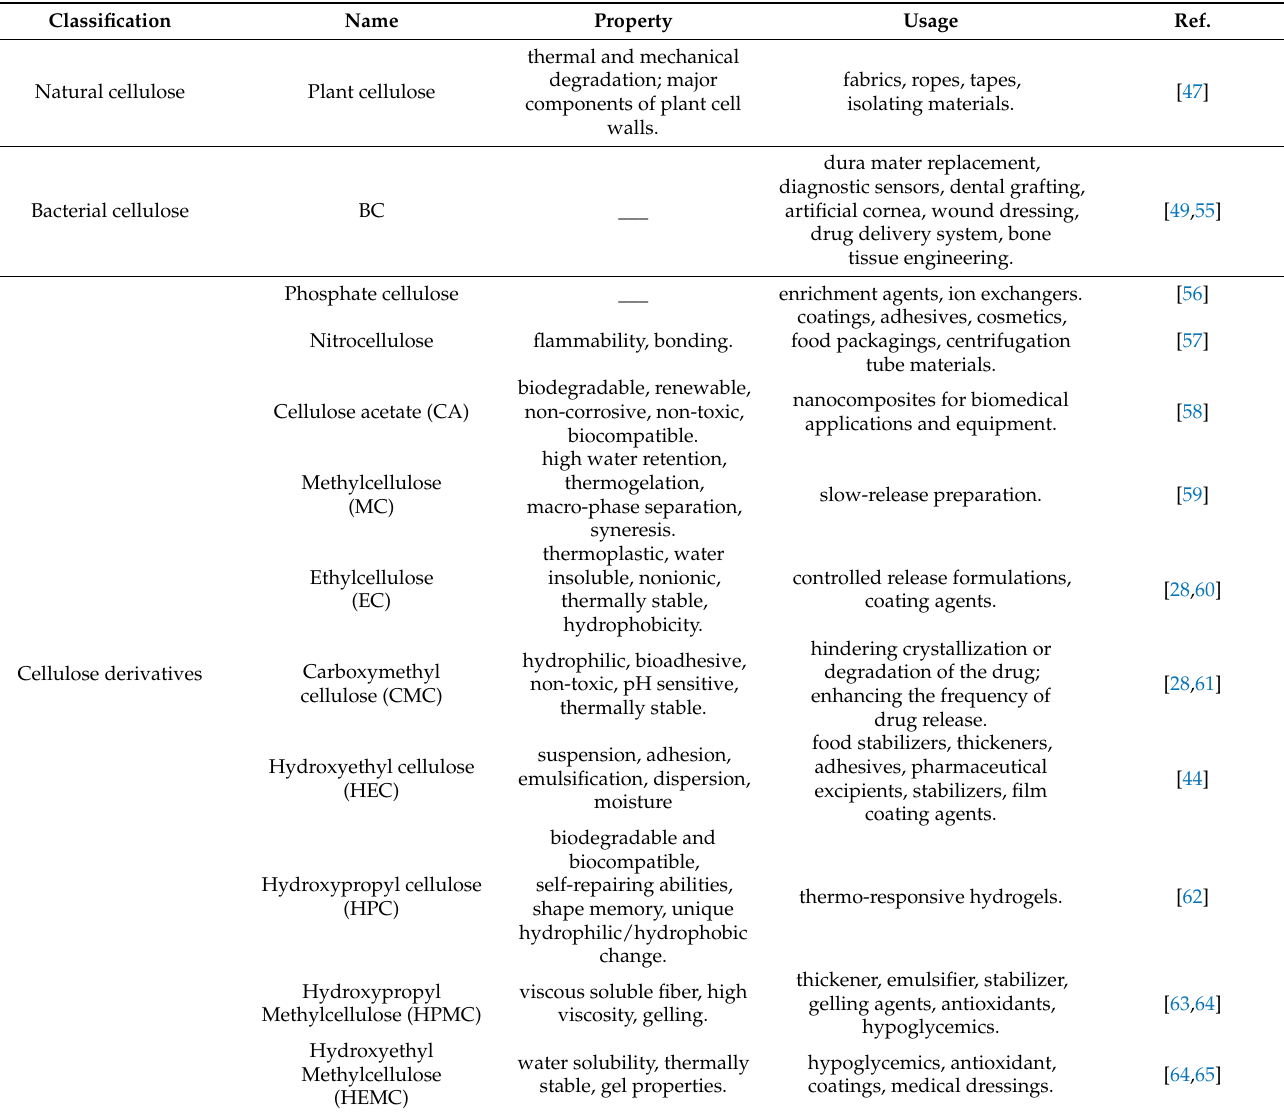
Table 1. Summary of the cellulose classification, property and usage.